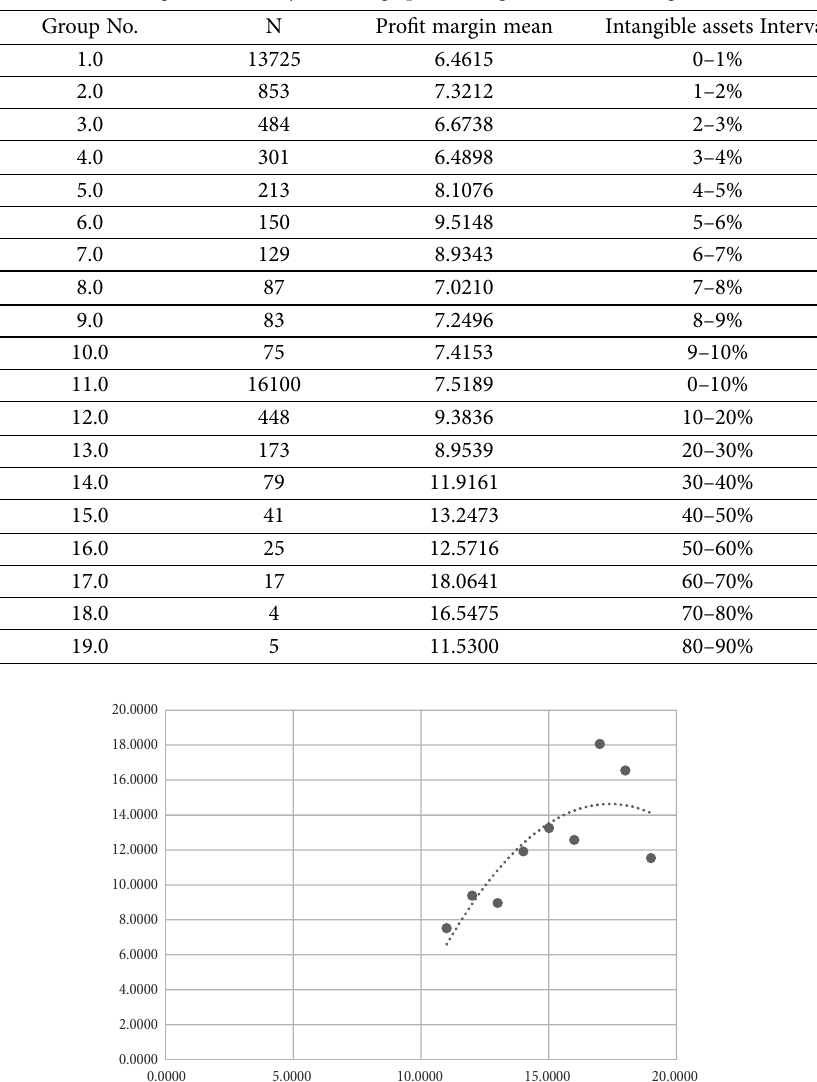
Fig. 3A. Graphical representation of mean profit margin by intangible assets intervals (polynomial